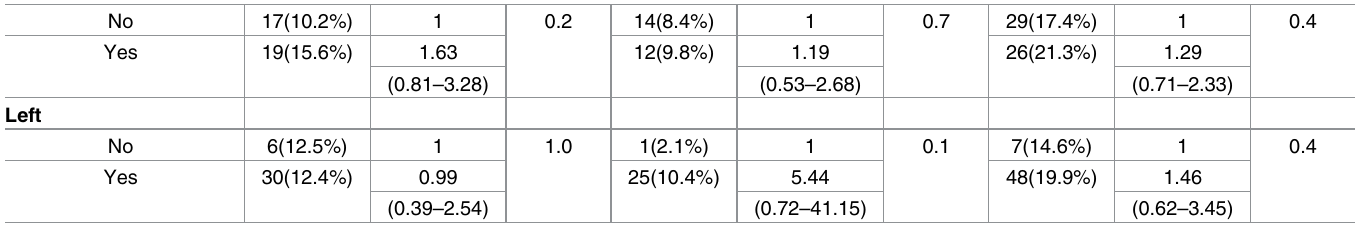
Table 4. Multivariate analysis of clinical and molecular characteristics of patients, adjusted for age and sex. OUTCOME OR 95% CI P -value Factors included in the analysis Min. Max.